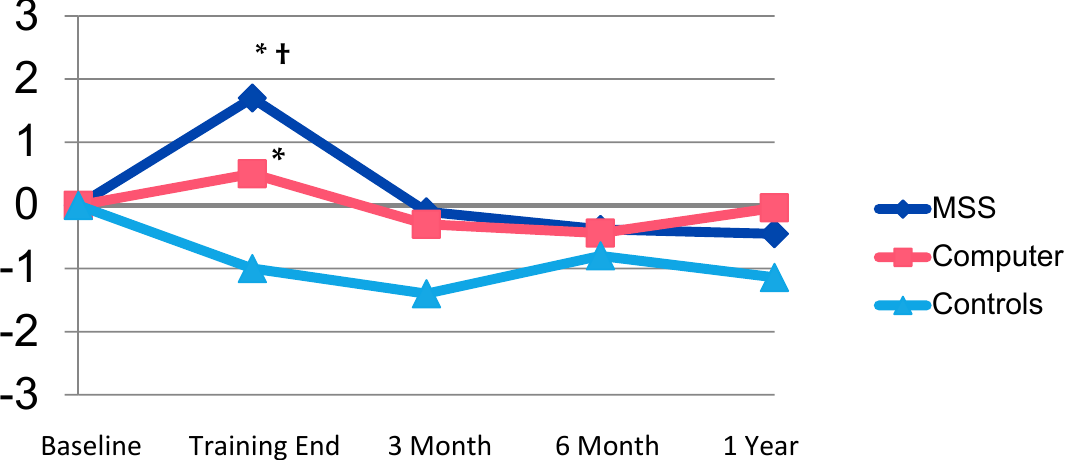
Figure 1. Change in Memory Activities of Daily Living Over Time. * p < 0.05 within-subject change. † p = 0.01 between-subject change for Memory Support System (MSS) compared to controls.